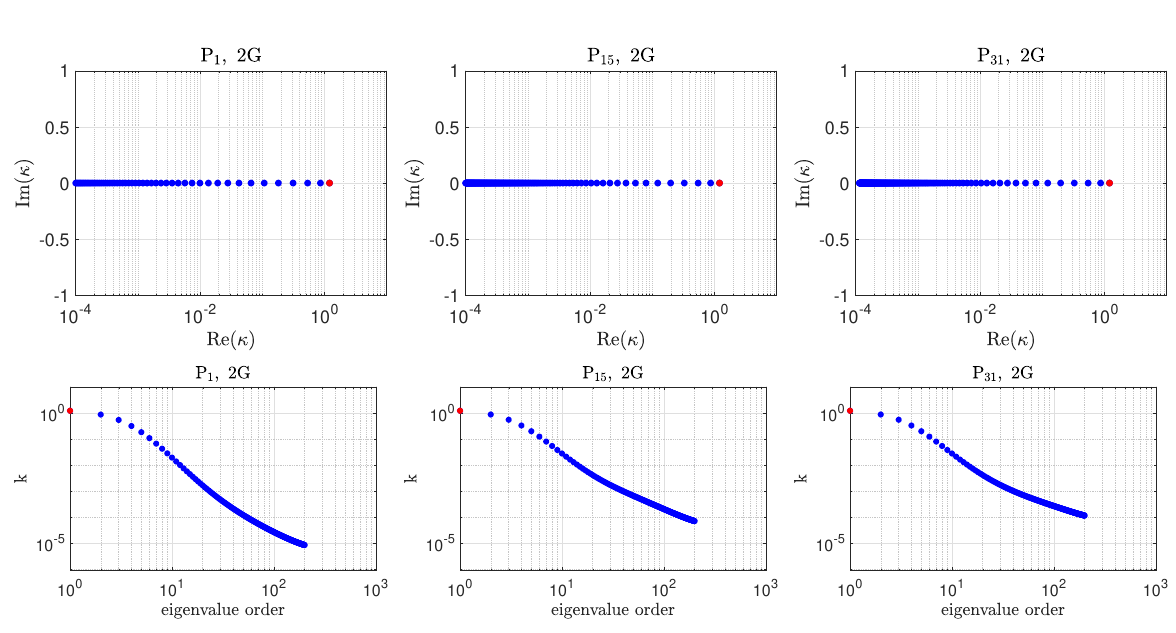
Figure 4: κ eigenvalue distribution for a symmetrically reflected system.